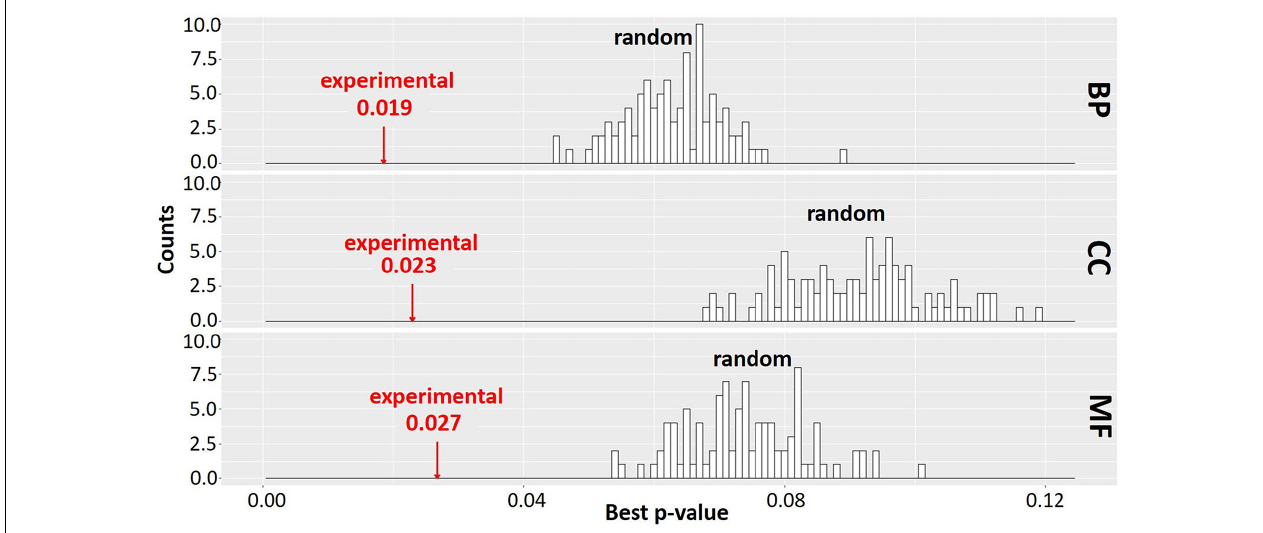
FIGURE 7 | Gene Ontology (GO) enrichment analysis of experimental data and random permutation test distribution. A Pearson correlation matrix of the Saccharomyces Genome Database (SGD)+ORF dataset was partitioned into clusters by Markov Cluster (MCL). Best p -values (mean of the lowest adjusted p -values for GO terms) were determined across all clusters of the experimental data and all clusters of random permutations, similar to Mentzen and Wurtele (2008); Supplementary Section 4 . Red arrow, experimental data. Black bars, best p -value of 100 randomly obtained permutations with size and number of clusters identical to experimental data. BP, biological process; CC, cellular component; MF, molecular function. The clustering result is significantly better for experimental data than any random permutation.